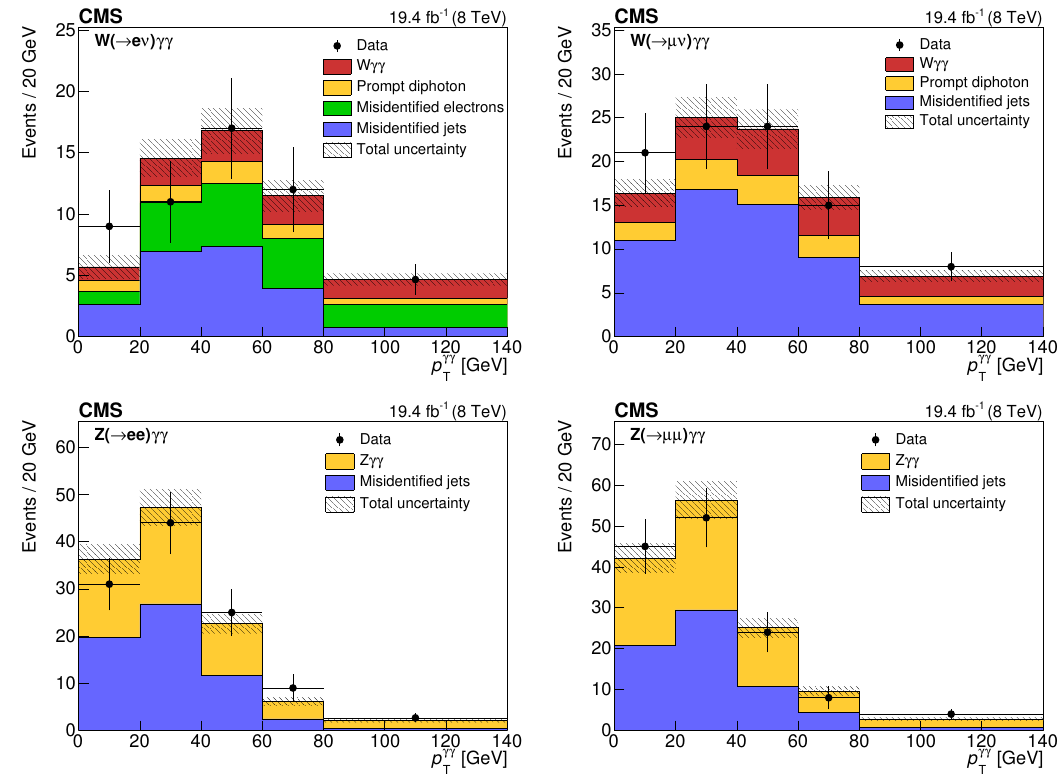
Figure 1 . Distributions of the diphoton p T for the W (cid:13)(cid:13) (upper) and Z (cid:13)(cid:13) (lower) analyses, in the electron (left) and muon (right) channels. The points display the observed data and the histograms show the predictions for the background and signal. The indicated uncertainties in the data points are calculated using Poisson statistics. The hatched area displays the total uncertainty in the sum of these predictions. The predictions for electrons and jets misidenti(cid:12)ed as photons are obtained with data-based methods. The remaining background and signal predictions are derived from MC simulation. The last bin includes all events in which the diphoton p T exceeds 80